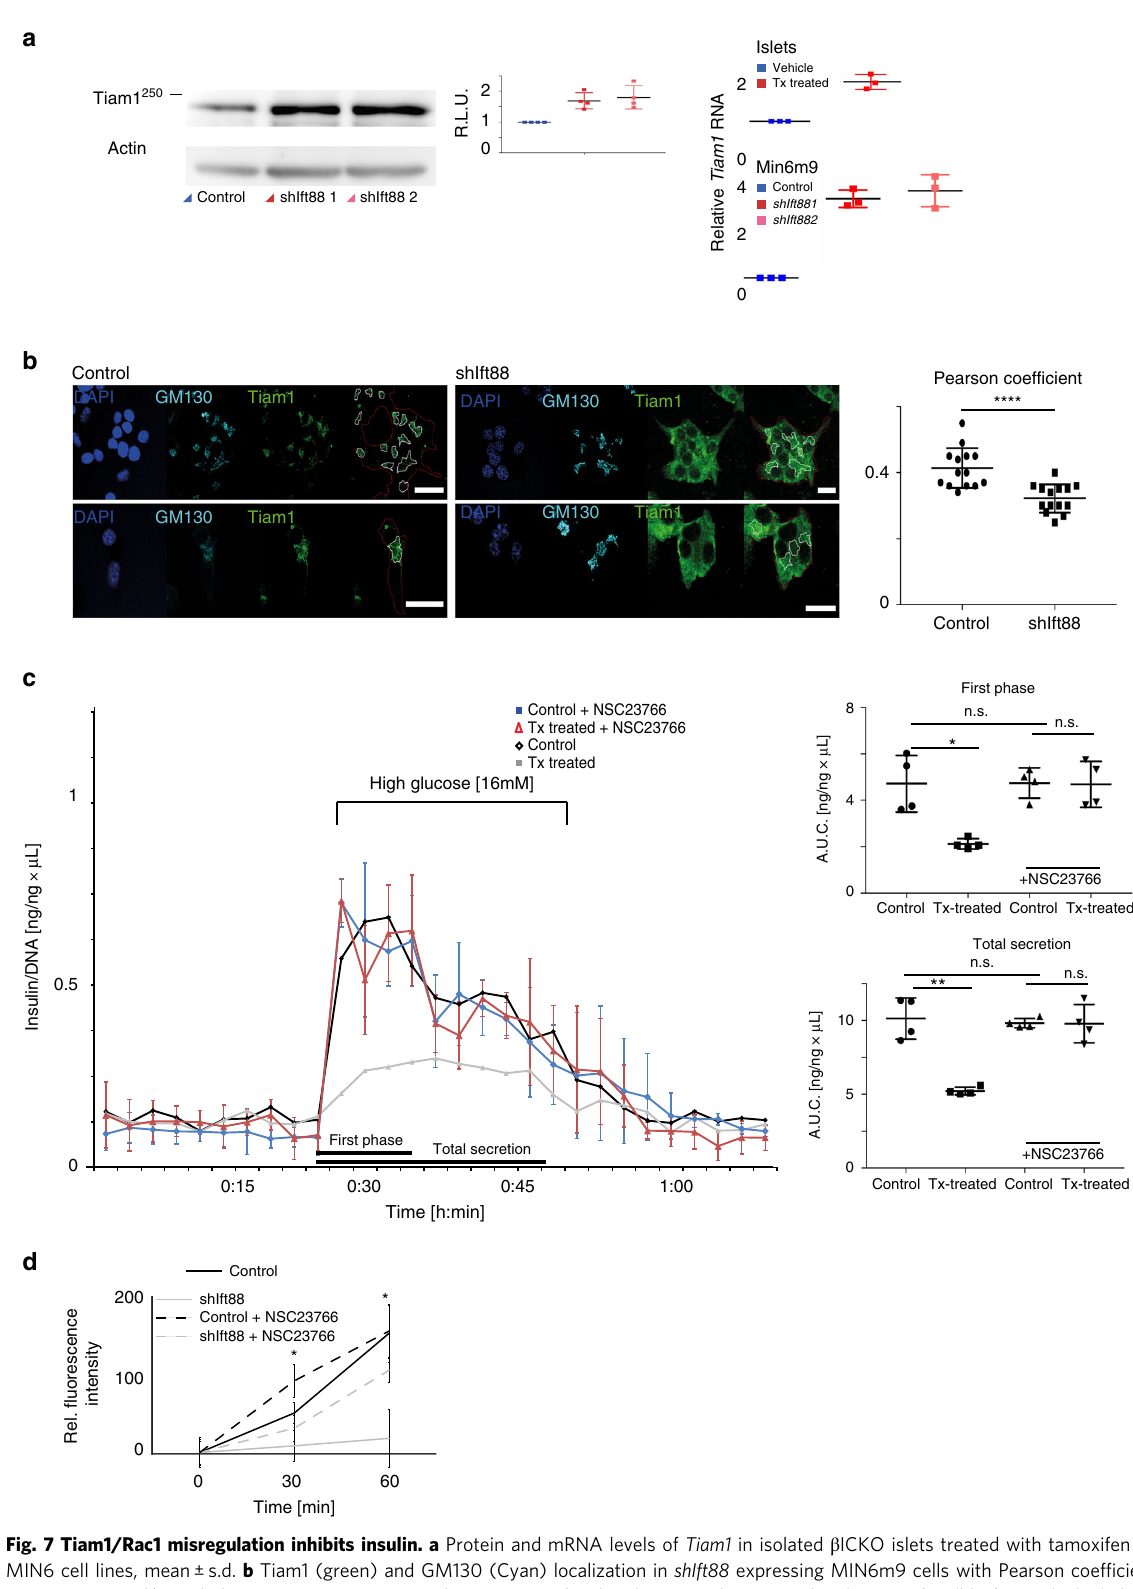
Fig. 7 Tiam1/Rac1 misregulation inhibits insulin. a Protein and mRNA levels of Tiam1 in isolated β ICKO islets treated with tamoxifen and vehicle and MIN6 cell lines, mean ± s.d. b Tiam1 (green) and GM130 (Cyan) localization in shIft88 expressing MIN6m9 cells with Pearson coef fi cient ( p < 0.0001, t test, mean ± s.d.). Scale bar 20 µ m. c Dynamic insulin secretion of isolated β ICKO islets treated with tamoxifen (blue) or vehicle (ethanol; red) treated with 20 μ M NSC23766. On the right, quanti fi cation of fi rst phase (AUC, time 18:00 to 30:00 min) and total secretion (AUC, from 18:00 to 48:00 min) (islets pooled from n = 10 animals, experiment repeated n = 4, and insulin measured n = 2 per experiment), in gray Tx-treated β ICKO islets and in black vehicle-treated β ICKO islets from Fig. 1f for comparison, mean ± s.d. d Biotinylated EphrinA5-Fc uptake in derivative MIN6m9 cells treated with NSC23766 and vehicle. ( n = 4, t = 30 min: Control vs shIft88 p = 0.0044, Control vs shIft88 + NSC23766: p = 0.0289; t = 60 min: Control vs shIft88 p = 0.0006, Control vs shIft88 + NSC23766 p = 0.1466 (ANOVA), mean ±